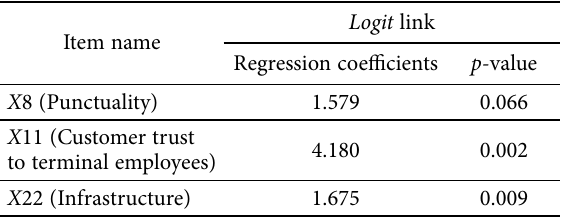
Table 3. Accuracy of the classification for response categories based on the regression model in logit link with 3 factors Actual response category